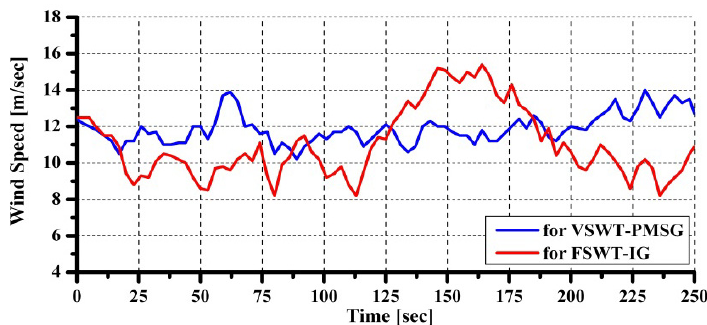
Figure 28. Wind speed data.